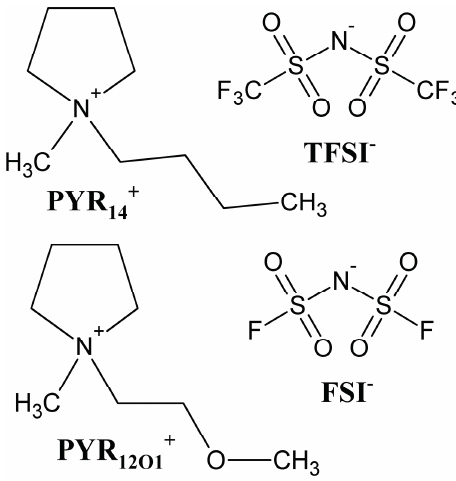
Figure 16. Molecular formulae of PYR 14+ , PYR 12O1+ , FSI − and TFSI − .